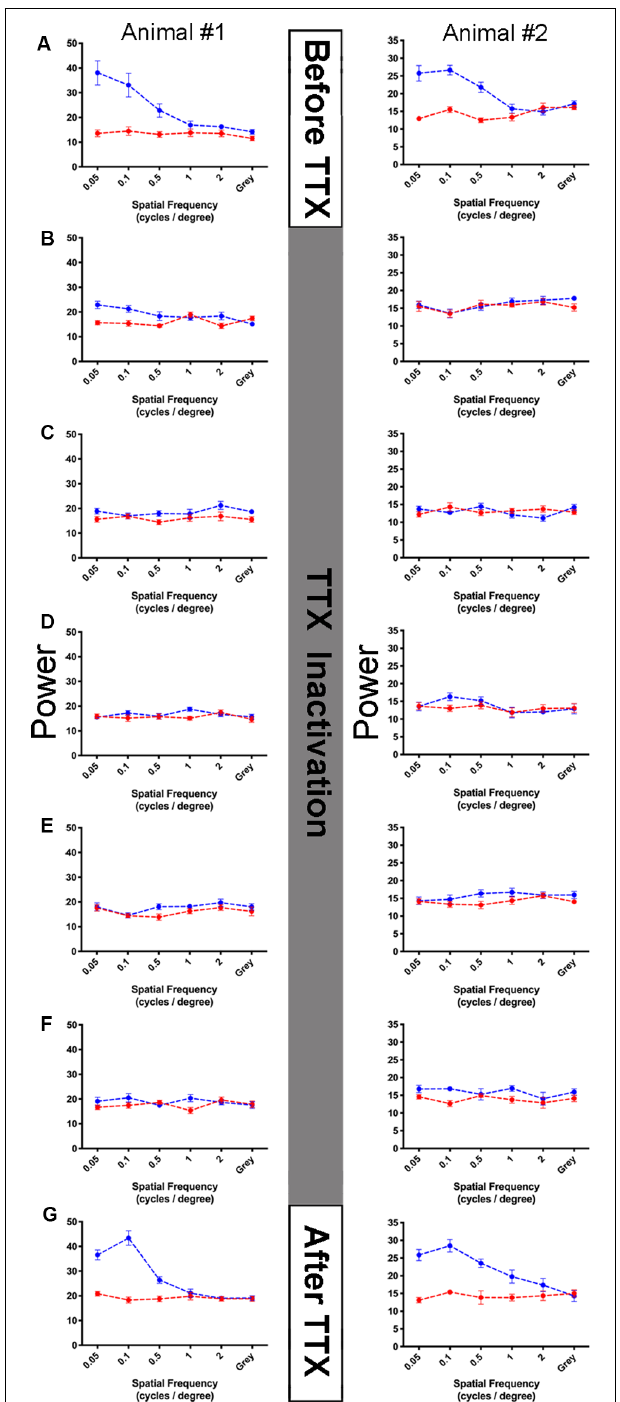
FIGURE 7 | Assessment of vision function before, during, and after retinal inactivation with intraocular administration of TTX. Visually-evoked potentials were measured from the primary visual cortex of two kittens (columns) throughout the course of a TTX inactivation experiment (rows A–G ). For each graph, spatial frequency is plotted on the abscissa, and summed power from the Fourier analysis is plotted on the ordinate (see “Materials and Methods” section). The blue points in each graph indicate the sum of visually-evoked ( Continued